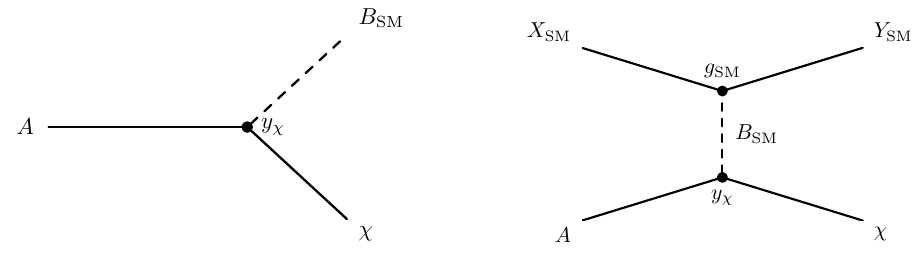
B SM (cid:31) (left) and X SM + A Y SM + (cid:31) (right). ! ! B SM (cid:31) , (cid:27) ( s ) the cross section for the process ! (only possible when thermal corrections A =T